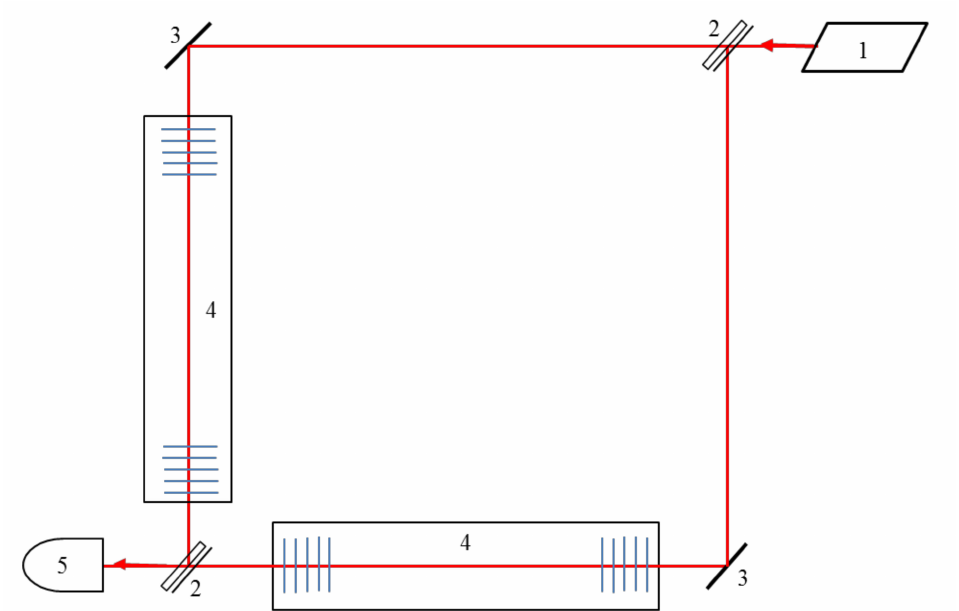
Figure 7. Optical scheme of Mach-Zehnder interferometer with periodical structures as reflecting mirrors. 1—laser, 2—beam splitter, 3—mirror, 4—Fabry-Perot resonator with periodical structures,